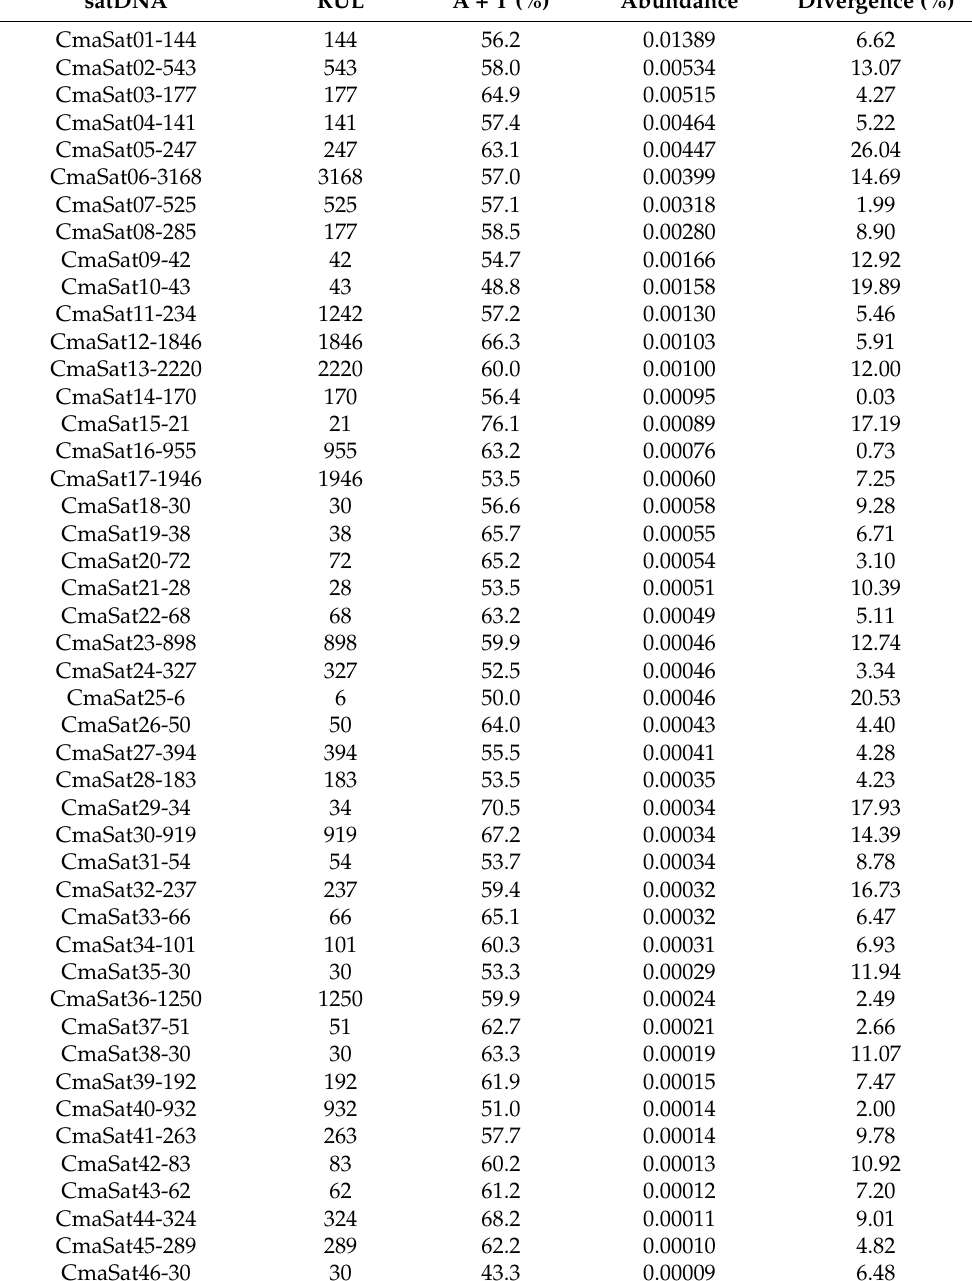
Table 2. Main features of C . macropomum